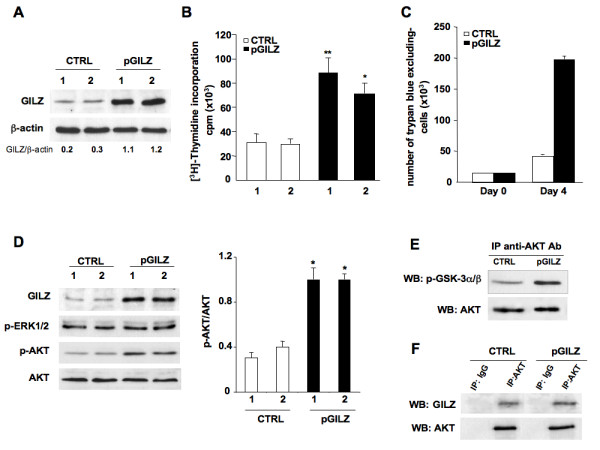
Up regulation of GILZ increases cell proliferation and AKT activation. (A) Total protein lysates analyzed by western bloting with anti-GILZ Ab in two CTRL and pGILZ clones. (B) Cell proliferation measured by [3H]-thymidine incorporation in two CTRL and pGILZ clones. Means ± SD of three independent experiments. Statistics used Kruskall Wallis test, *P < 0.05, **P < 0.01. (C) Number of trypan blue-excluding cells among CTRL and pGILZ clones seeded at 15 × 103 cells/well and cultured for 4 days. Means of triplicates of one representative experiment of three; error bars represent SE. (D) Left: total protein lysates from CTRL or pGILZ clones cultured overnight without serum analyzed by western blotting using specific Abs. Right: p-AKT signal quantified by densitometric analysis and normalized to total AKT. Mean ± SE of three experiments, *P < 0.05, unpaired Student's t test. (E) Total lysates from CTRL or pGILZ were immunoprecipitated (IP) using an anti-AKT Ab, and then incubated with GSK-3-fusion protein in an in vitro kinase assay. GSK-3 phosphorylation was assessed by western blot (WB) with phospho-specific GSK-3 Ab. Total AKT was used for normalization. (F) Total protein lysates from BG-1 cells were immnunoprecipitated with anti-AKT Ab or control rabbit IgG, and submitted to western blotting with anti-GILZ Ab. After stripping, membranes were reblotted with anti-total AKT mouse Ab. Blots: one representative experiment of three.